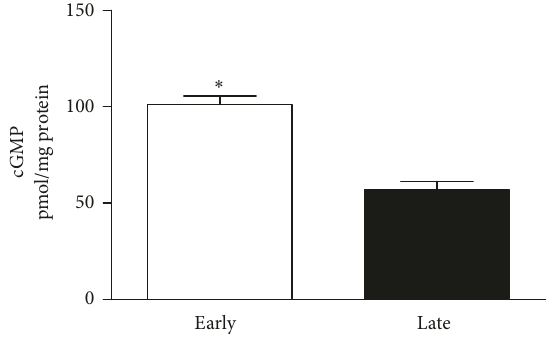
Figure 3: Estrogen-induced production of cyclic guanosine monophosphate (cGMP) in GSMC from early- and late-pregnant rats. Incubation with estrogen (E2) significantly increased cGMP levels in GSMC. Values shown are representative of three experiments performed in triplicate. Samples were collected from 6 early-pregnant and 7 late-pregnant rats. ∗ measurements in early-pregnant rats are significantly different ( P < 0.05) from corresponding measurements in late-pregnant rats.